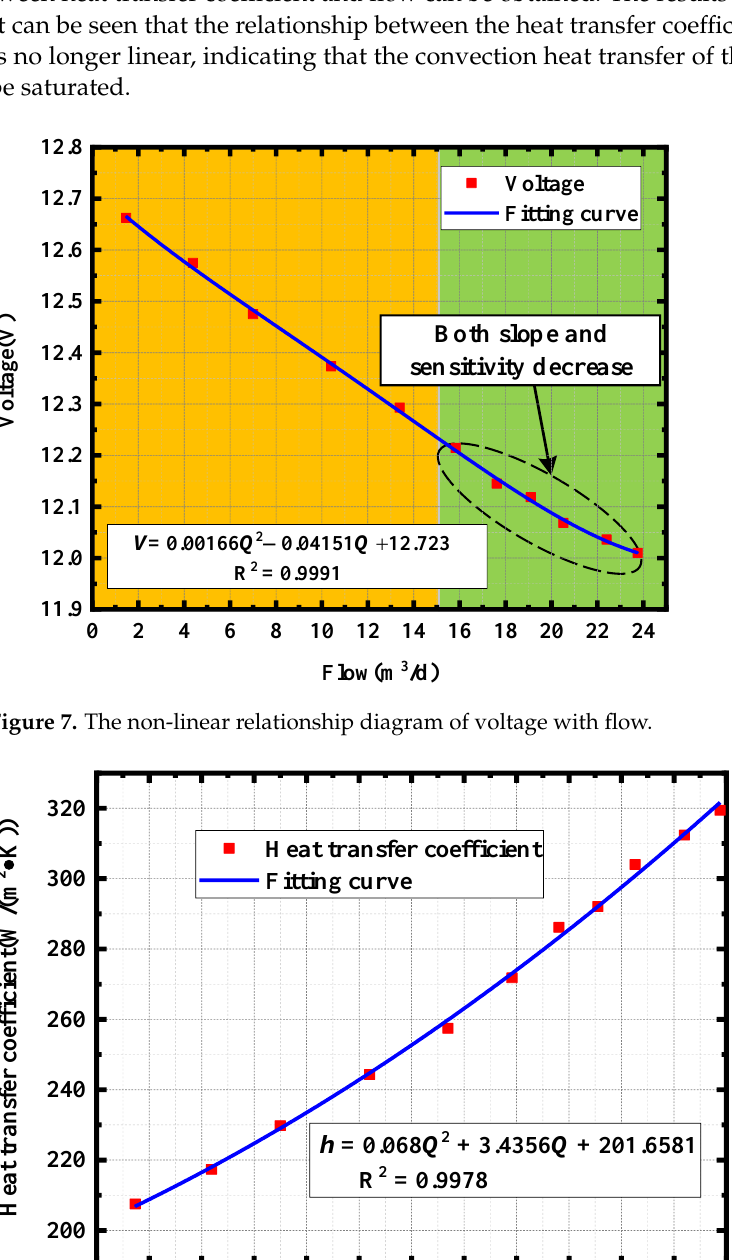
Figure 6. Linear diagram of voltage versus flow rate.